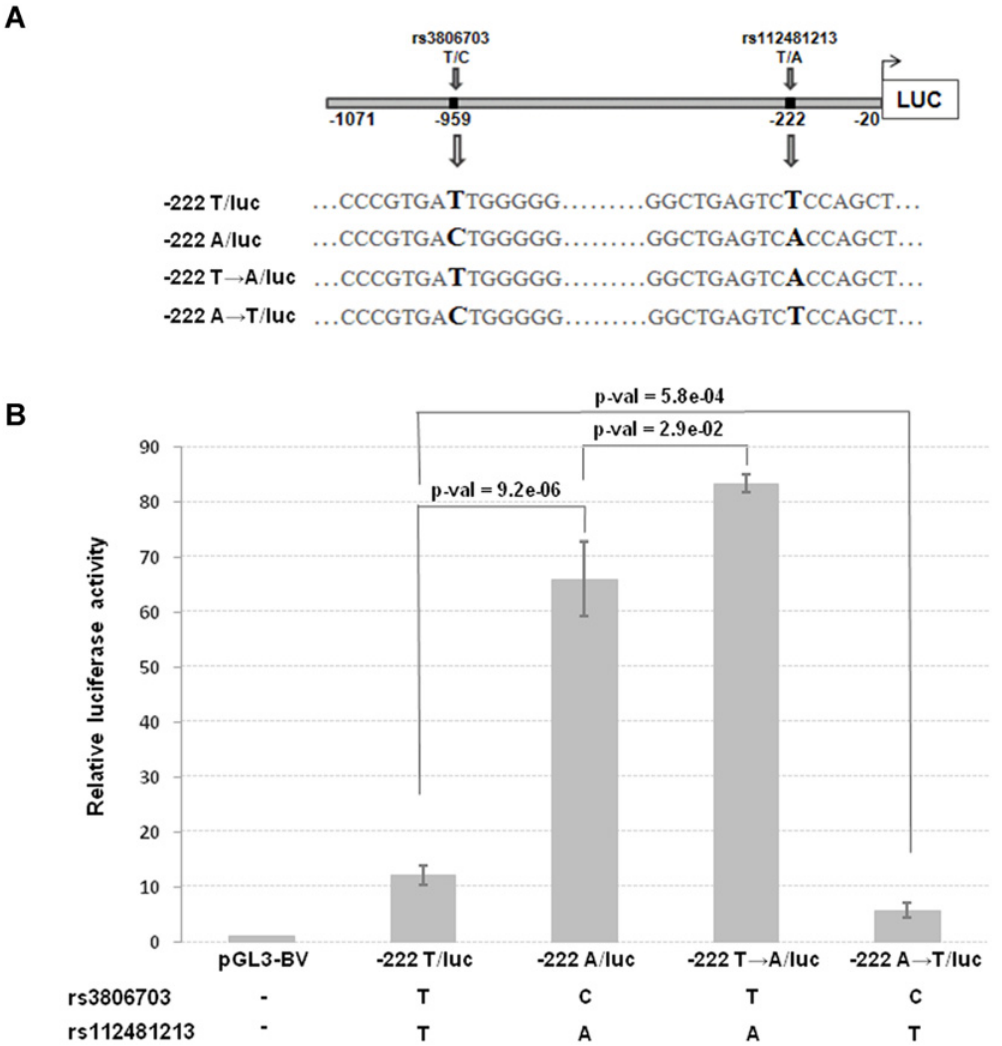
Fig 3. Transcriptional activity and schematic representation of reporter constructs. (A) The two constructs (222A/luc and-222T/luc) contain a 1,051 bp region including the 5 ’ UTR and 342 bp upstream the transcription start site of CRIPTO and differ for the rs112481213 allele. The-222A ! T/luc and 222T ! A/ luc constructs derive from a site-directed mutagenesis at the rs112481213 SNP position. (B) NTERA2 cell line was transfected with firefly luciferase reporter constructs carrying 1,051bp of the CRIPTO gene with either the A allele or the T allele at rs112481213. The rs112481213 A allele produced a 5-fold increase in luciferase activity compared to the T allele. Site-mutated constructs at the rs112481213 allowed to discriminate the effect of rs112481213 and rs3806703 on the transcription. Data are presented as fold-induction compared with promoter-less vector (pGL3-BV). Data are shown as mean ± SD from five